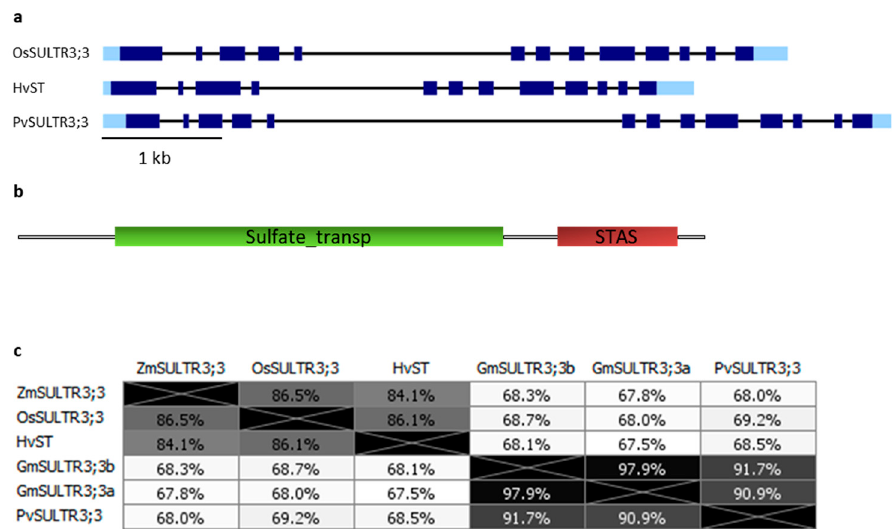
Figure 3. ( a ) Gene structure of OsSULTR3;3, HvST and putative PvSULTR3;3 genes. Light and dark blue rectangles represent UTRs and coding exons, respectively, the black bars correspond to introns. Table 1. a legend. ( b ) Predicted domains of the SULTR3;3 protein. The sulfate transporter and the anti-sigma factor antagonist (STAS) domains are represented in red and green, respectively. Picture reproduced from [84]. ( c ) Distances between SULTR3;3 proteins, expressed as the percentage of identity. Phylogenies were constructed as described in Figure 1c.